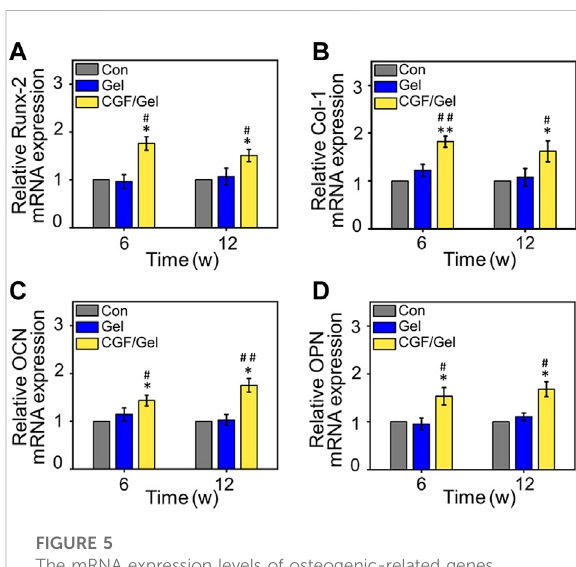
FIGURE 5 The mRNA expression levels of osteogenic-related genes, including (A) Runx-2 , (B) Col-1 , (C) OCN , and (D) OPN in the regenerated bone tissue ( n = 3) (* p < 0.05 compared with Con group; # p < 0.05, ## p < 0.01 compared with Gel